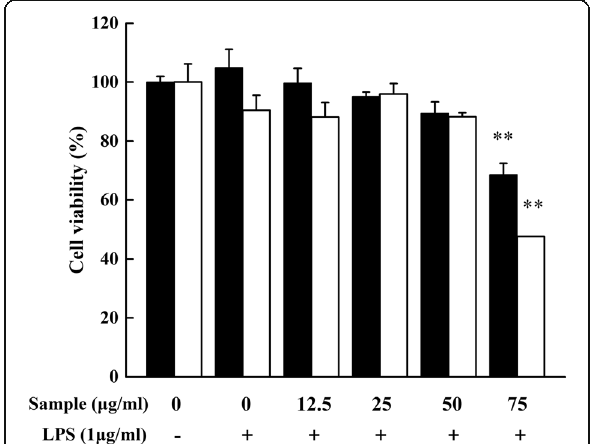
Fig. 2 Cytotoxicity of YYHs on RAW 264.7 cells. Cells were treated in the presence of YYHs or in combination with LPS (1 μ g/mL) for 24 h. Cell viability was determined by MTT assay (black bar, YYHs treated; white bar, YYHs+LPS treated). Compared with the control, # P < 0.05, ## P < 0.01. Compared with LPS group, * P < 0.05, ** P <